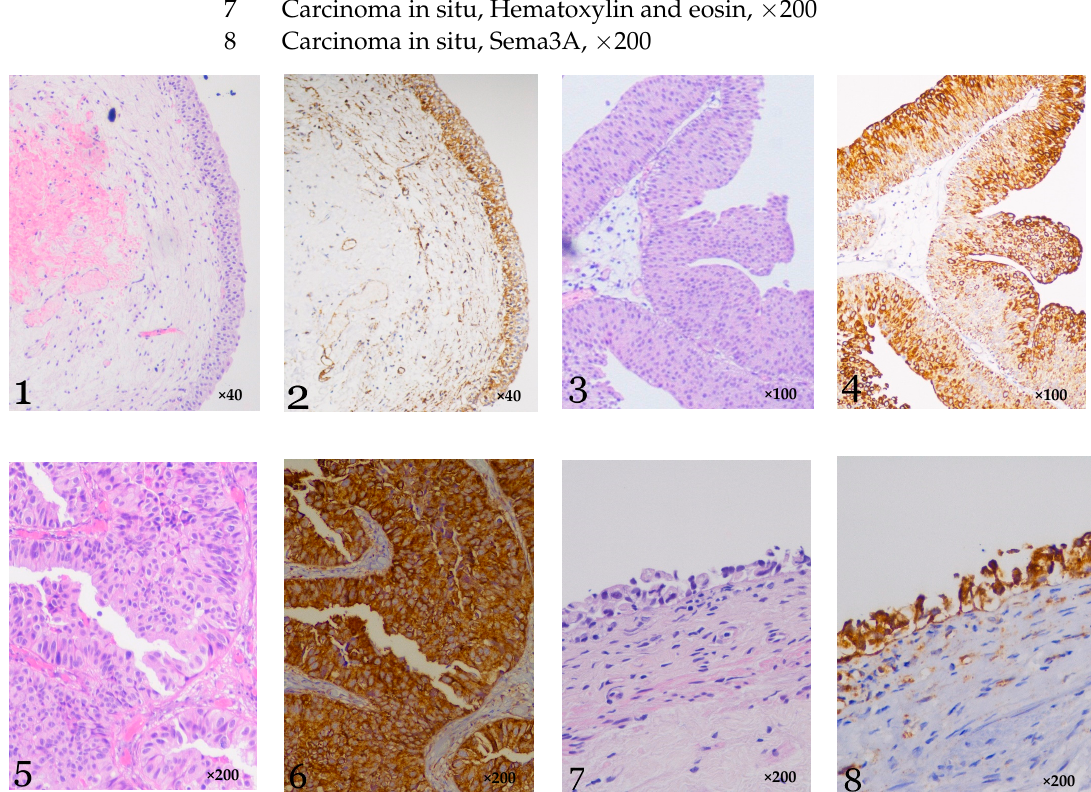
Figure 1. Hematoxylin & Eosin staining vs. Sema 3A immunohistochemical staining of: Normal bladder ( 1 , 2 ), Low grade papillary urothelial carcinoma ( 3 , 4 ), High grade urothelial carcinoma ( 5 , 6 ), and Carcinoma in situ ( 7 , 8